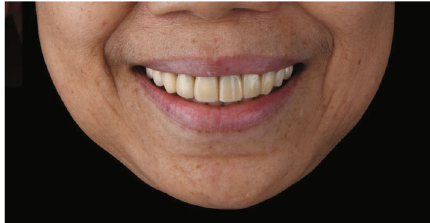
Figure 6: Provisional crowns in the patient ’ s mouth on the day of the